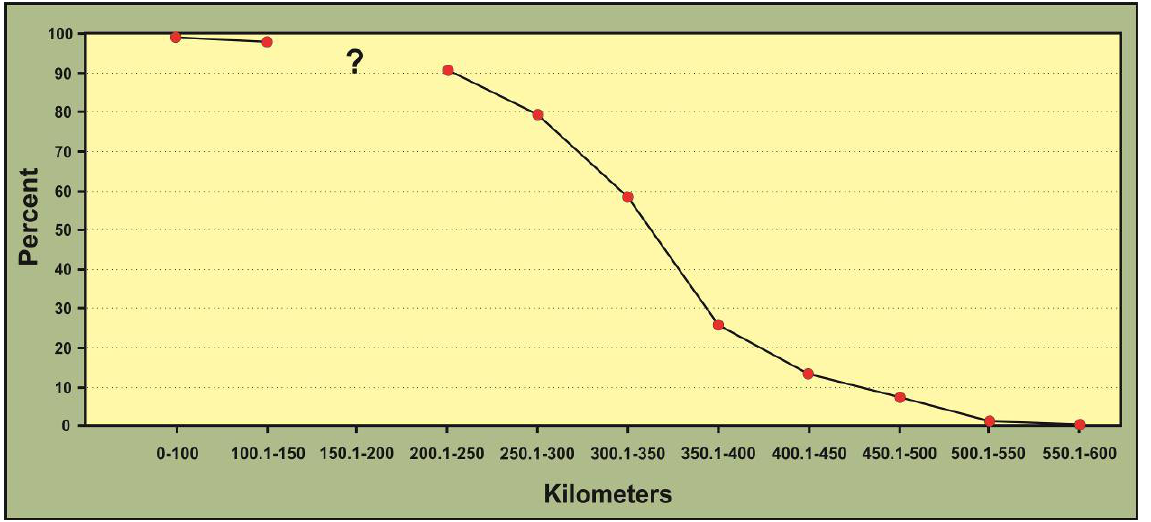
Figure 5. Percentage fall-off of Tandilia sources with distances into 50 km intervals. The gap (?) is linked to the absence of detailed published information about the probable provenance of lithic resources recovered in those